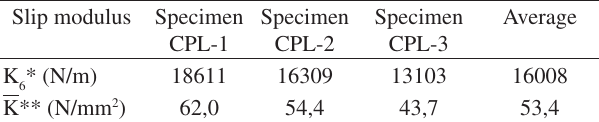
Table 2. Determination of the equivalent slip modulus from the test results.